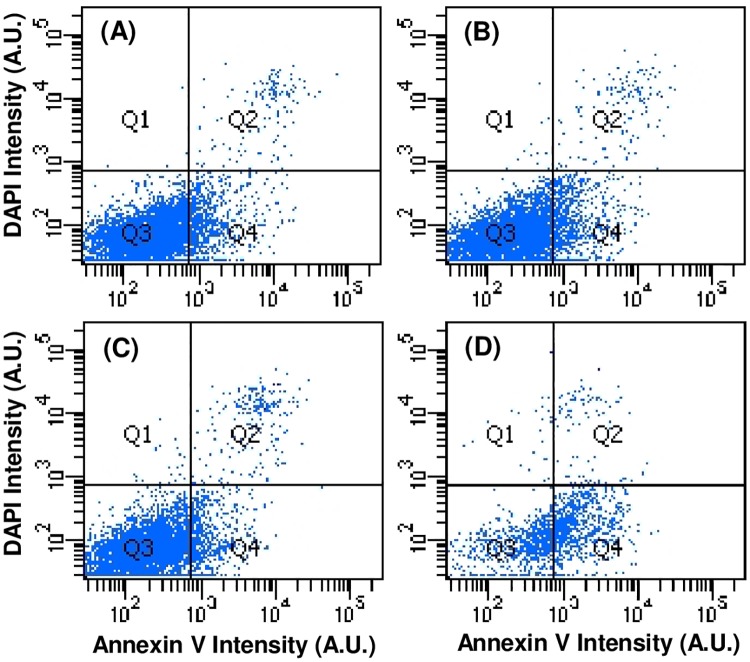
Flow cytometry data for BAECs stained with Annexin V and counterstained with DAPI.Staining was done immediately after subjecting cells to rapid depressurization (A) or slow depressurization (B) following a 3 hr application of elevated hydrostatic pressure. Results for a negative control (C: atmospheric pressure) and a positive control (D: treatment with 1 μM staurosporine for 24 hrs) are also shown. Annexin V and DAPI fluorescence intensity, in arbitrary units (A.U.), are given on the abscissa and ordinate, respectively. Cytometry data is presented as four quadrants superimposed over the resulting DAPI vs. Annexin V plots to distinguish between necrotic cells (DAPI positive/Annexin negative), late stage apoptotic cells (DAPI positive/Annexin positive), healthy cells (DAPI negative/Annexin negative), and early stage apoptotic cells (DAPI negative, Annexin positive).